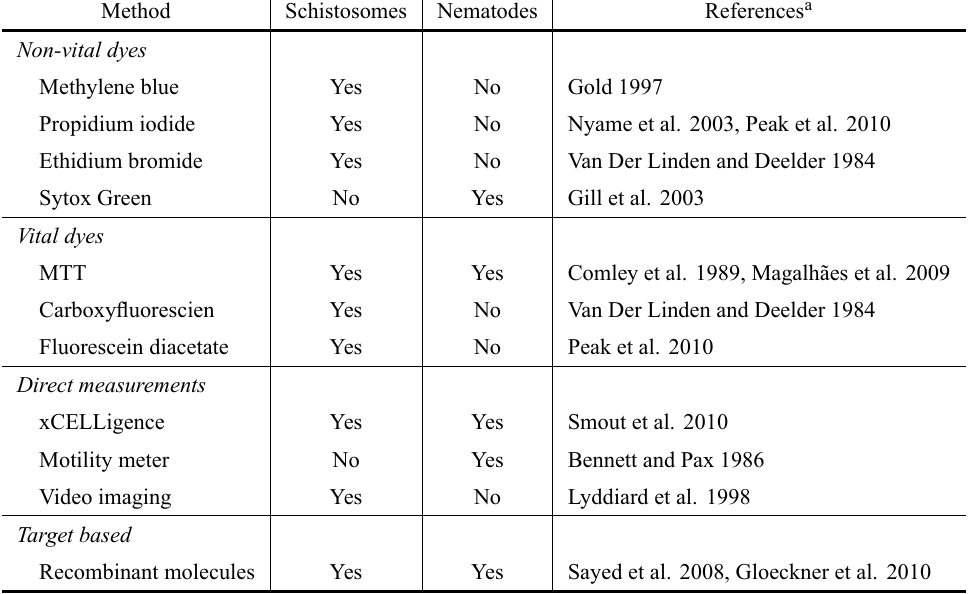
Complementary methods for assessing helminth viability and identifying novel